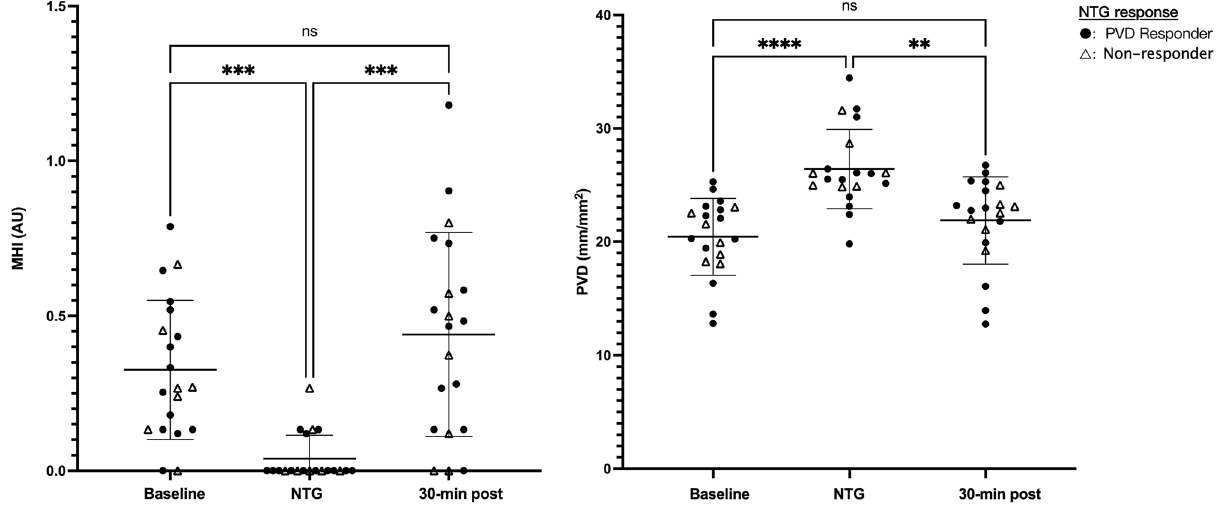
Figure 1. Individual response to the nitroglycerin (NTG) challenge. Thirteen out of 20 subjects experienced a PD response the topical nitroglycerin. Bars representing the mean with 95% CI. **p < 0.01, ***p < 0.001, ****p < 0.0001.